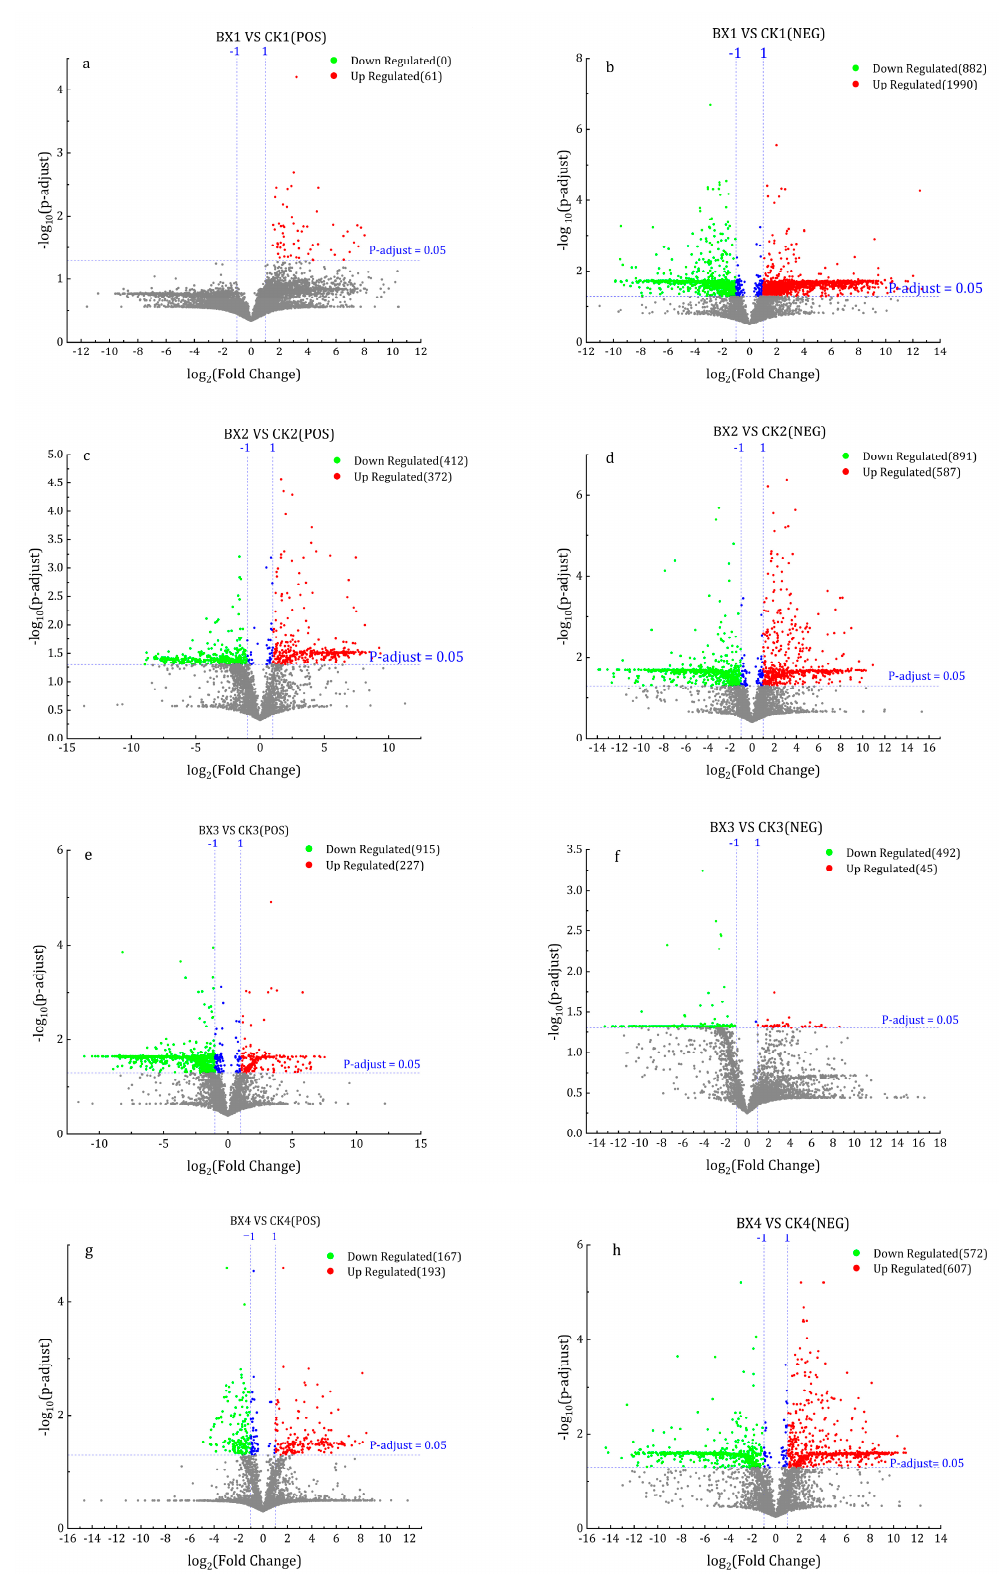
Figure 8. Volcano plot of DMs. Horizontal is log 2 (Fold Change) and ordinate is − log 10 ( p -adjust value). Red means up-regulation DMs, green means down-regulation DMs and grey means no significant DMs. ( a , c , e , g ): DMs in positive ion mode, ( b , d , f , h ): DMs in negative ion mode. ( a , b ): bx1 vs. ck1; ( c , d ): bx2 vs. ck2; ( e , f ): bx3 vs. ck3; ( g , h ): bx4 vs.